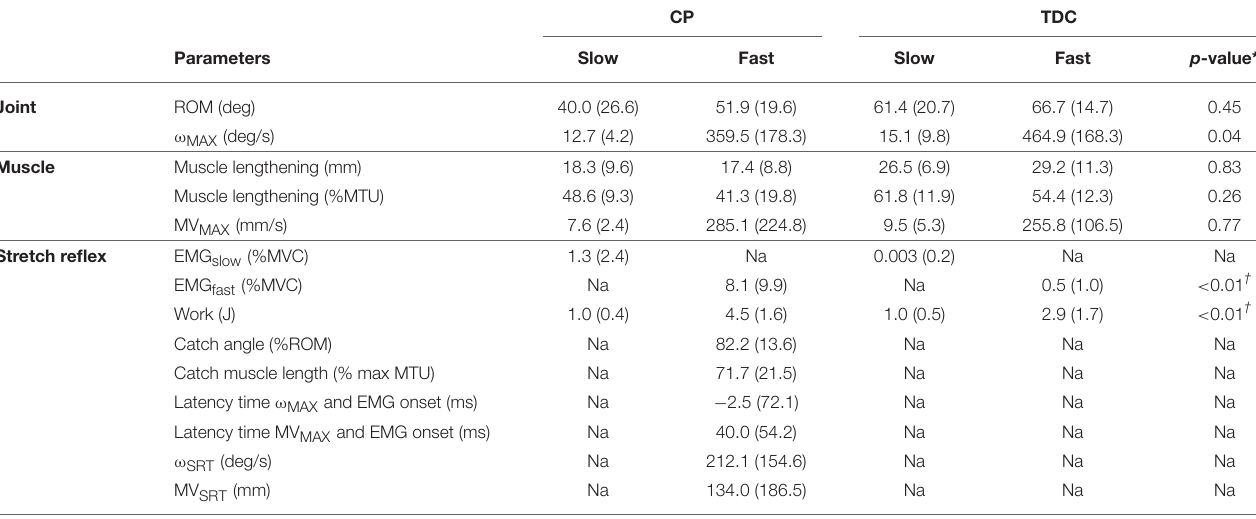
TABLE 2 | Median (and IQR) of all outcome parameters during sow and fast ankle rotations in children with cerebral palsy (CP) and typically developing children